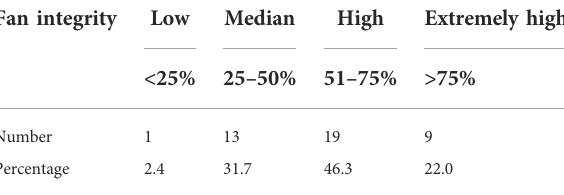
TABLE8Thefansintegrityclassi fi cationoftheFujiangRiverupstream. Fan